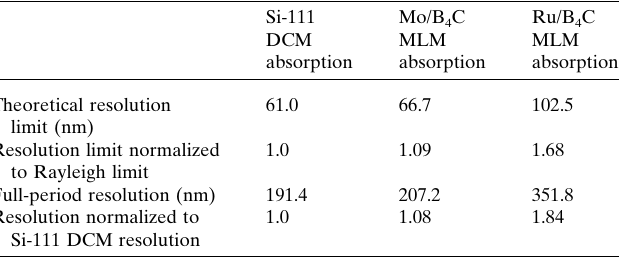
Table 6 The resolution limit as determined from the azimuthal profiles. The theoretical resolution limit has been calculated using the measured energy bandwidths discussed in the paper.